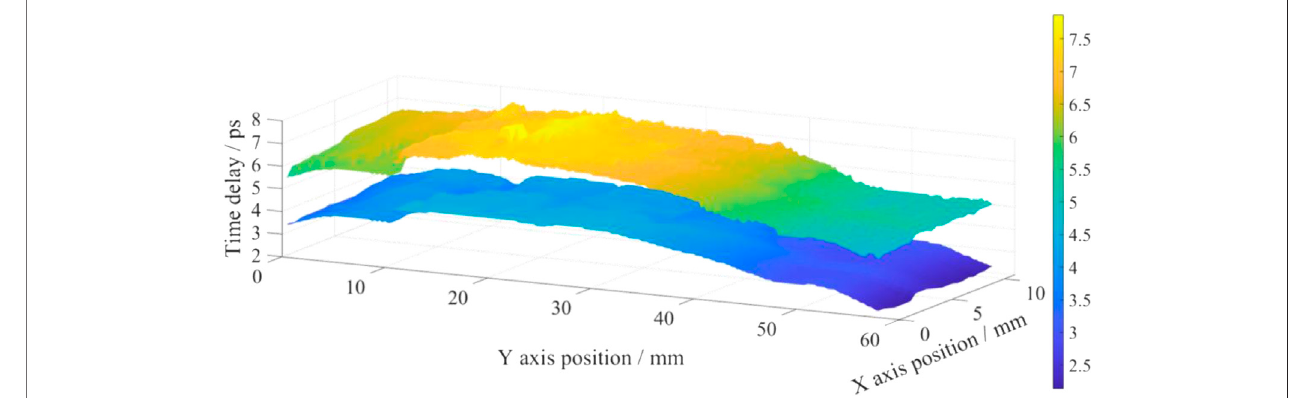
FIGURE 9 | Time-of- fl ight